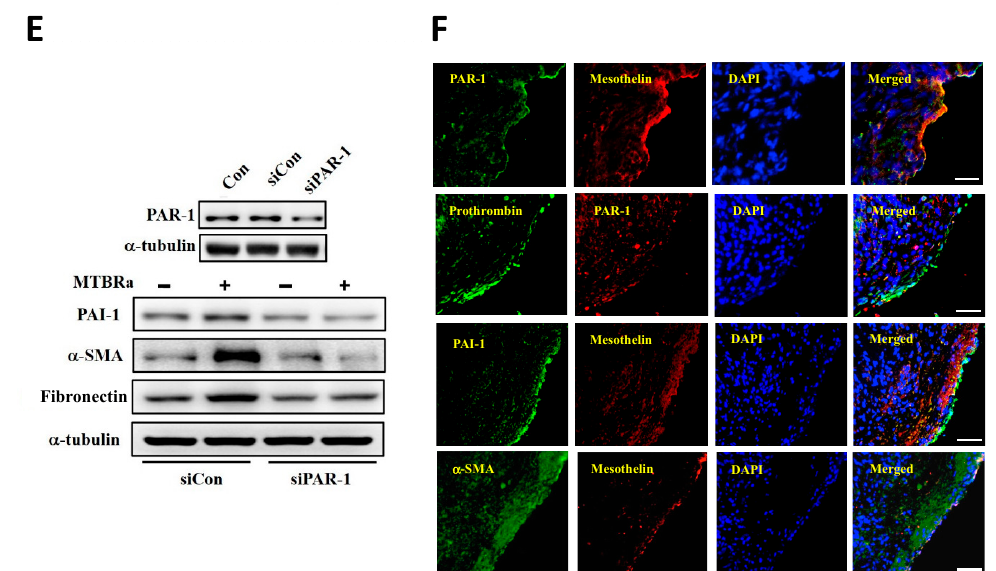
Figure 6. MTBRa induces expression of tissue factor and prothrombin to increase production of thrombin that upregulates PAI-1 expression and mmT through PAR-1 in human PMCs and associates with expression of PAR-1, prothrombin, PAI-1 and α -SMA in pleural mesothelium of patients with TBPE. ( A ) The thrombin level in the conditioned medium of MTBRa-treated MeT-5A cells was measured by ELISA. ( B ) The expression of tissue factor and prothrombin in MTBRa-treated MeT-5A cells was assessed by Western blotting assay. ( C , D ) The mRNA level of tissue factor and prothrombin in MTBRa-treated MeT-5A cells was assessed by semi-quantitative reverse transcriptase PCR. ( E ) The expression of PAI-1, α -SMA and fibronectin was determined by Western blotting assay in MeT-5A cells pretreated with control siRNA (siCon) or PAR-1 siRNA (siPAR-1) followed by the stimulation of MTBRa (10 ng / mL) for 24 h. ( F ) Immunofluorescence staining of mesothelin (red), PAR-1 (green or red), prothrombin (green), PAI-1 (green), or α -SMA (green) was performed on the para ffi n-embedded pleural mesothelium from patients with TBPE. Cells were also co-stained with DAPI to visualize nuclei (blue). Scale bar, 100 µ M. Data are presented as the means SEM ( n = 3). * p < 0.05, ** p < 0.01, *** p < 0.001 compared with vehicle group. MTBRa, Mycobacterium tuberculosis H37Ra; PAI-1, plasminogen activator inhibitor-1; mmT, mesothelial–mesenchymal transition; PAR-1, protease-activated receptor-1; PMC, pleural mesothelial cell; siRNA, small interfering RNA; α -SMA, α -smooth muscle actin; DAPI, 4 0 , 6-diamidino-2- phenylindole.